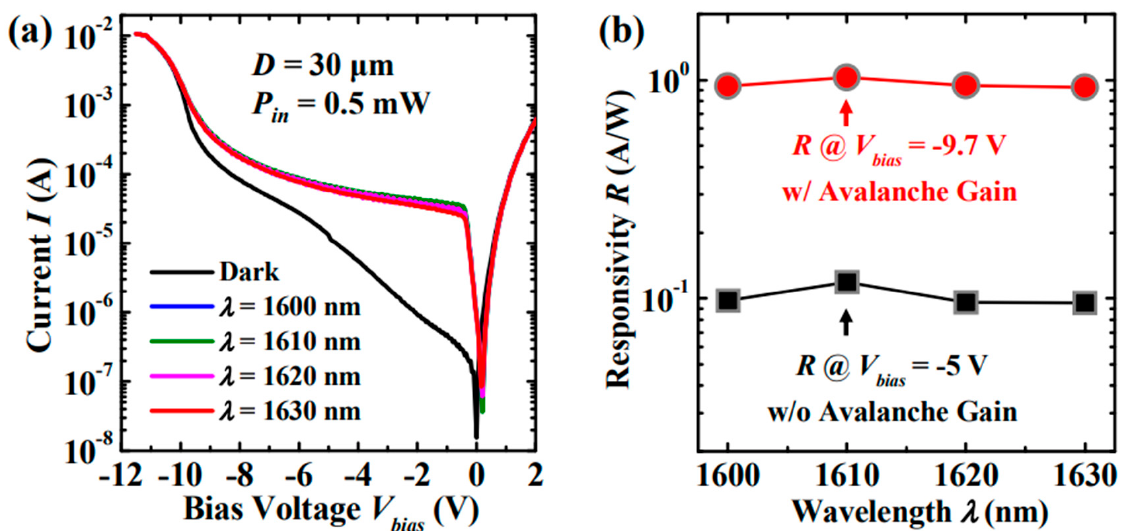
Figure 16. ( a ) I-V bias characteristics of GeSn/Si APD under the illumination of 1600 nm, 1610 nm, 1620 nm, and 1630 nm incident laser light; ( b ) relationship between responsivity and wavelength at − 5 V and − 9.7 V. Reproduced with permission from [74], IEEE, 2014.